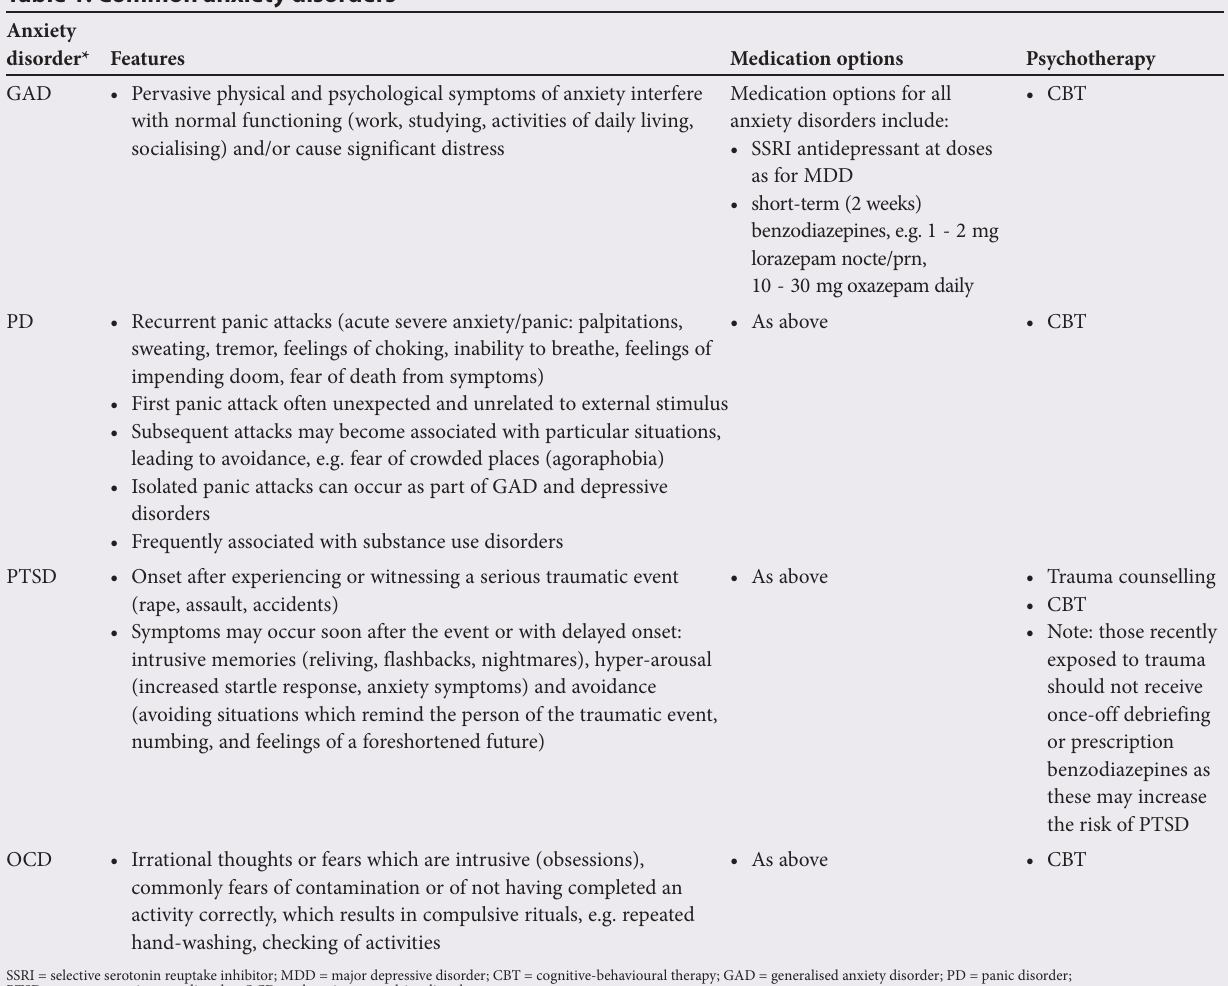
Table 1. Common anxiety disorders Anxiety disorder*